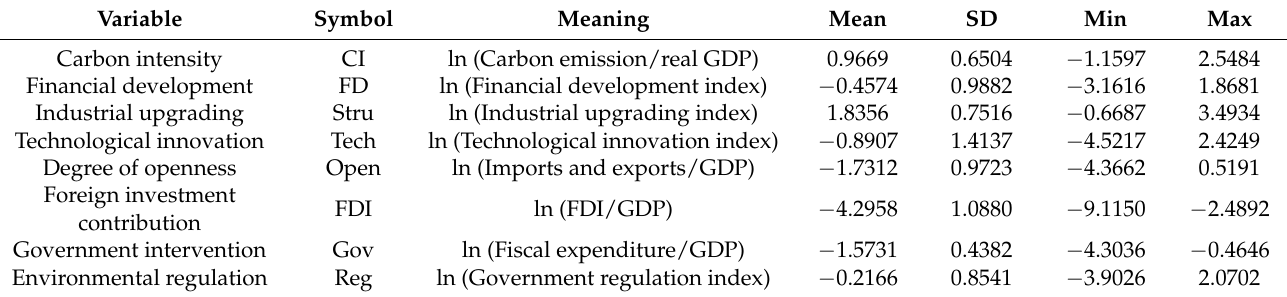
Table 2. Variables and descriptive